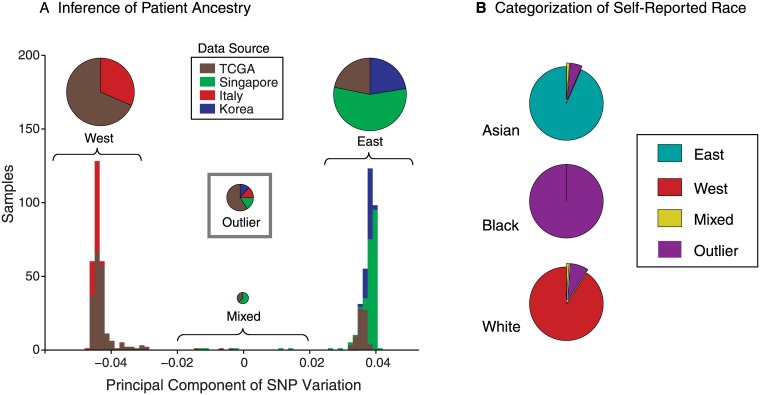
Classification of patient ancestry.(A) Distribution of projections of patient germline SNP genotypes on the principle component of SNP variation. The stacked bars of the histogram are colored by the data source and summarized in overlying proportionately sized pie charts. Outliers do not appear in the histogram. (B) Ancestries determined by genotype among patients reporting Asian, Black, and White ancestry, respectively.